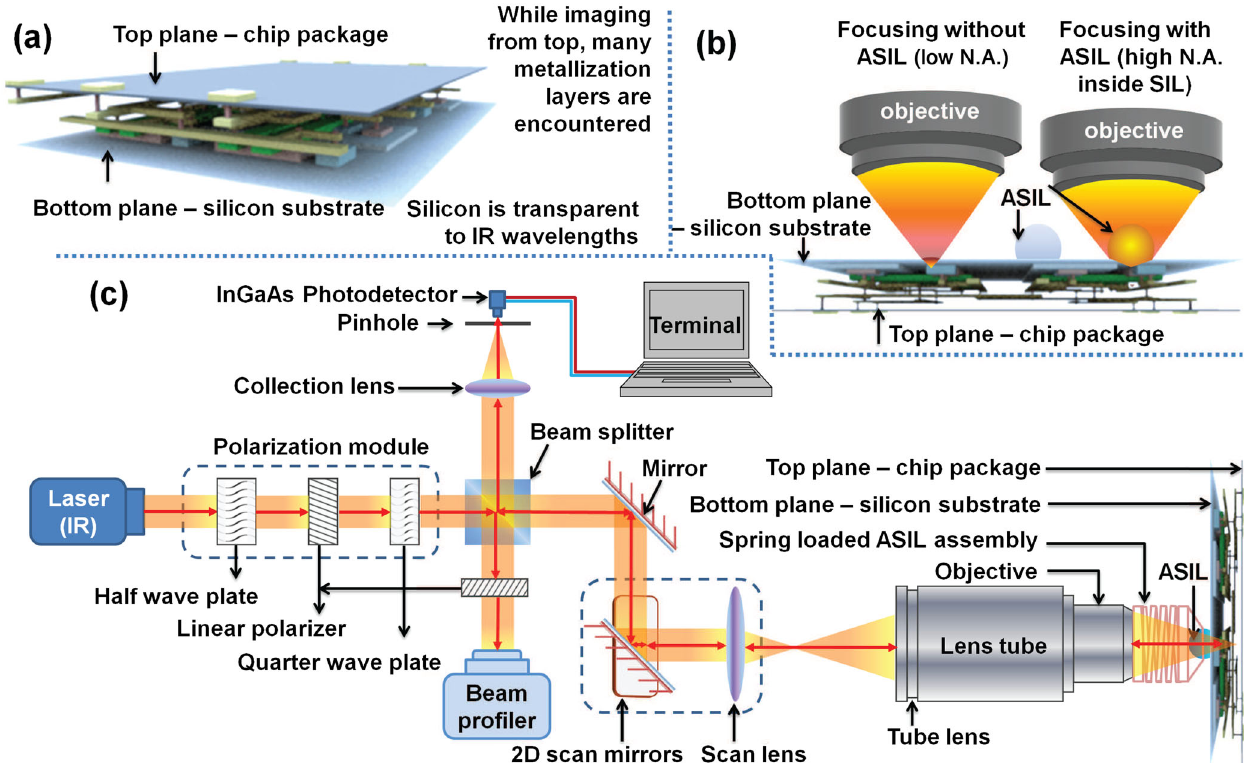
FIG. 1. Use of ASIL for imaging integrated circuits. Imaging through the top surface is difficult due to the presence of many metallization layers, seen in yellow in (a). On the other hand, imaging through the bottom plane is feasible since the transistor structures are typically in the first layer from the bottom and the silicon substrate is transparent to near-infrared waves (a). As opposed to imaging using only an objective lens, using an additional aplanatic solid immersion lens increases the effective N.A. inside the SIL, thus providing better resolution (b). The experimental setup of the ASIL scanning microscope is shown in